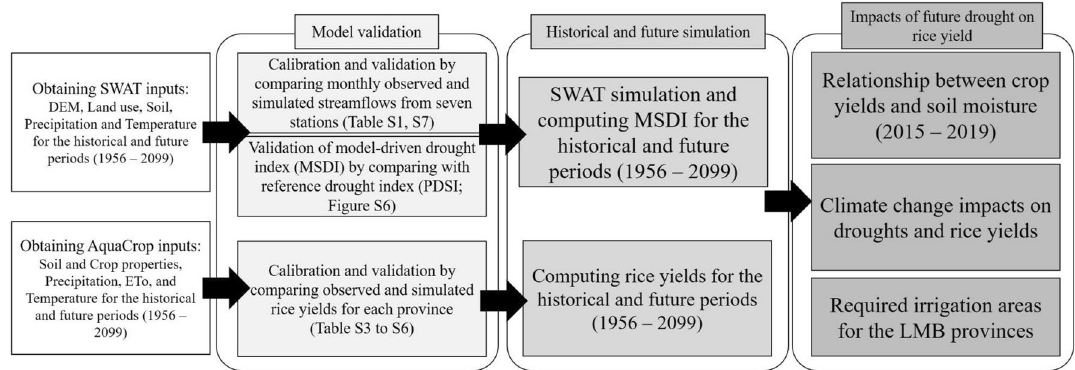
Figure 1. The process flow diagram showing hydrological and crop simulations. SWAT Soil and Water Assessment Tool, MSDI Multivariate Standardized Drought Index, PDSI Palmer Drought Severity